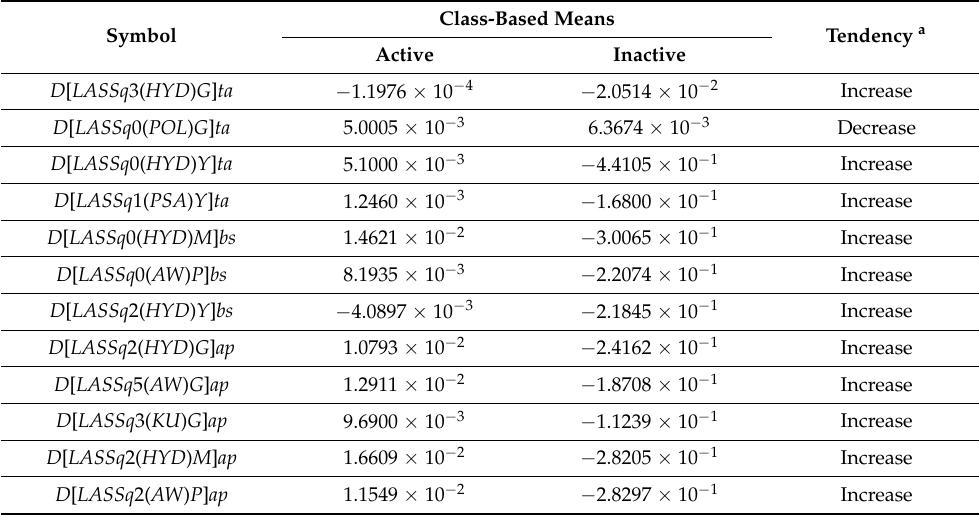
Table 4. Tendencies of variation calculated for the different molecular descriptors in the mtc-QSAR-EL model according to the class-based mean